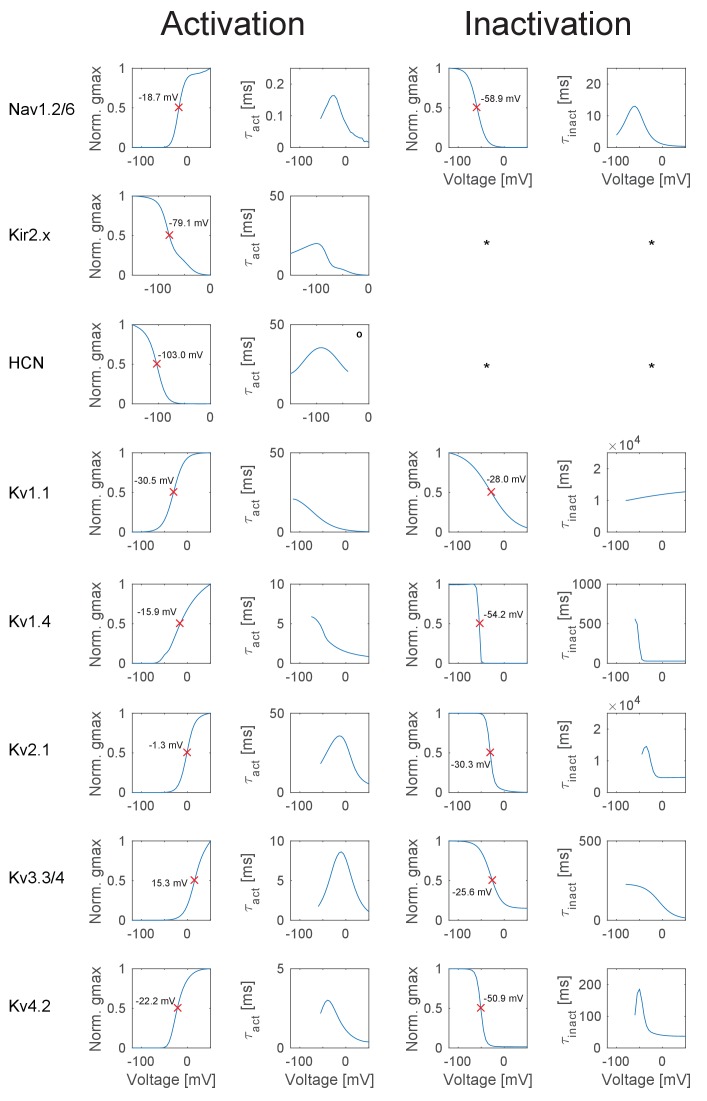
Overview of the ion channel activation and inactivation kinetics in the GC model.The illustrated voltage-dependent kinetics were automatically calculated and plotted with a function of the T2N package, which applied voltage step protocols to a single compartment comprising only the ion channel of interest. First column: Activation curves of all ion channels used in the GC model. The red crosses denote the half-activation voltage, which is additionally inserted as text in each case. Second column: Curve of the activation time constant at different voltages obtained with a monoexponential fit to the rise in conductance. Degree symbol (°) denotes that only the fast inactivation component was fitted. Third column: Inactivation curves of all ion channels used in the GC model. The red crosses denote the half-inactivation voltage, which is additionally inserted as text in each case. Fourth column: Curve of the inactivation time constant at different voltages obtained with a monoexponential fit to the decay in conductance. Asterisk (*) denotes cases where no inactivation occurred, e.g. for the hyperpolarization-activated ion channels Kir2.x and HCN.